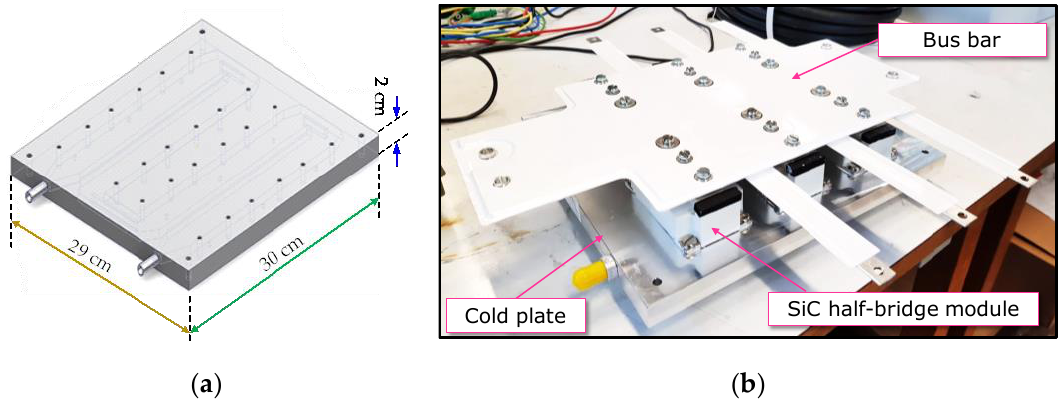
Figure 10. ( a ) CAD model of liquid-cooling cold plate, ( b ) placement of SiC half-bridge modules and a bus bar on top side of the cold plate.